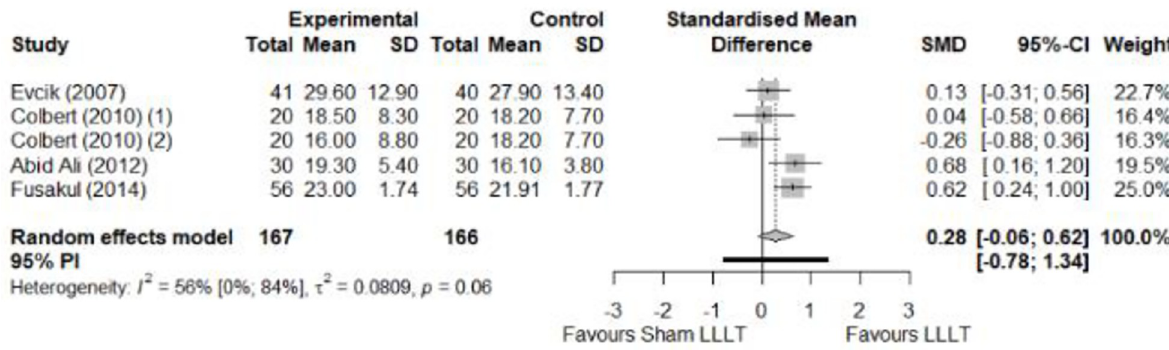
Fig 9. Analysis—Electrophysical modalities versus placebo (sensory nerve action potential amplitude). Studies with more than two intervention groups (different modalities, treatment doses, or symptom classification) were numbered as (1) and (2).